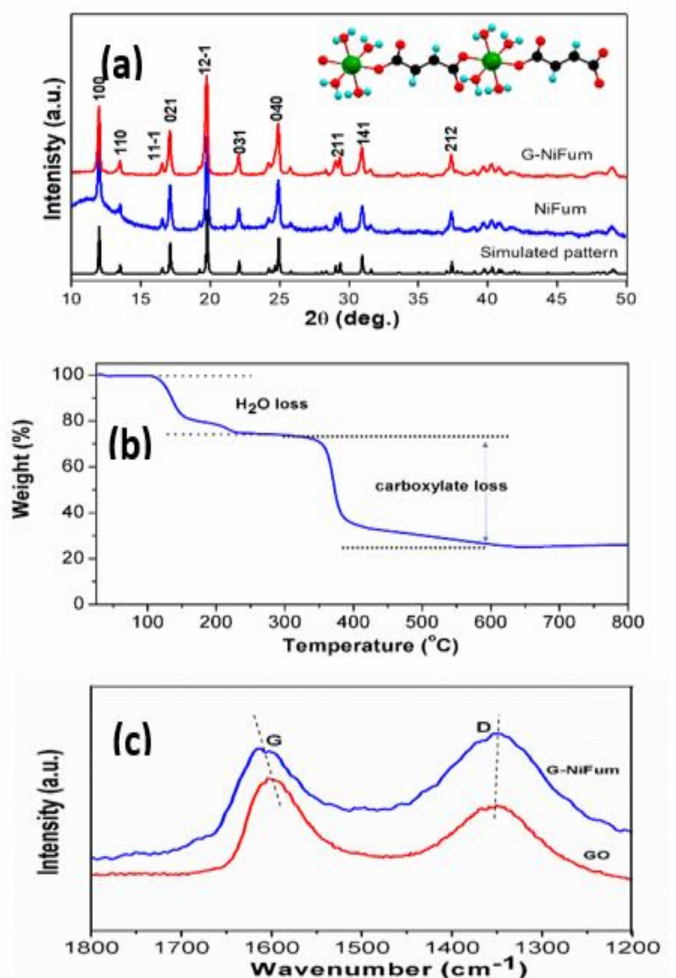
Figure 1. ( a ) Powder X-ray diffraction patterns of NiFum and G-NiFum compared with its sim- ulated pattern. Crystallographic representation of the one-dimensional polymeric structure of Ni(C 4 H 2 O 4 )(H 2 O) 4 . is shown in the inset of Figure 1a. The green, black-, red-, and blue-coloured balls represent nickel, carbon, oxygen, and hydrogen atoms, respectively; ( b ) thermogravimetric pro- files of NiFum in a nitrogen atmosphere at 5 ◦ C min − 1 ; ( c ) comparison of Raman spectra of G-NiFum with that of graphene oxide (GO). The reduction of GO during the synthesis is demonstrated by the increase in the I D /I G